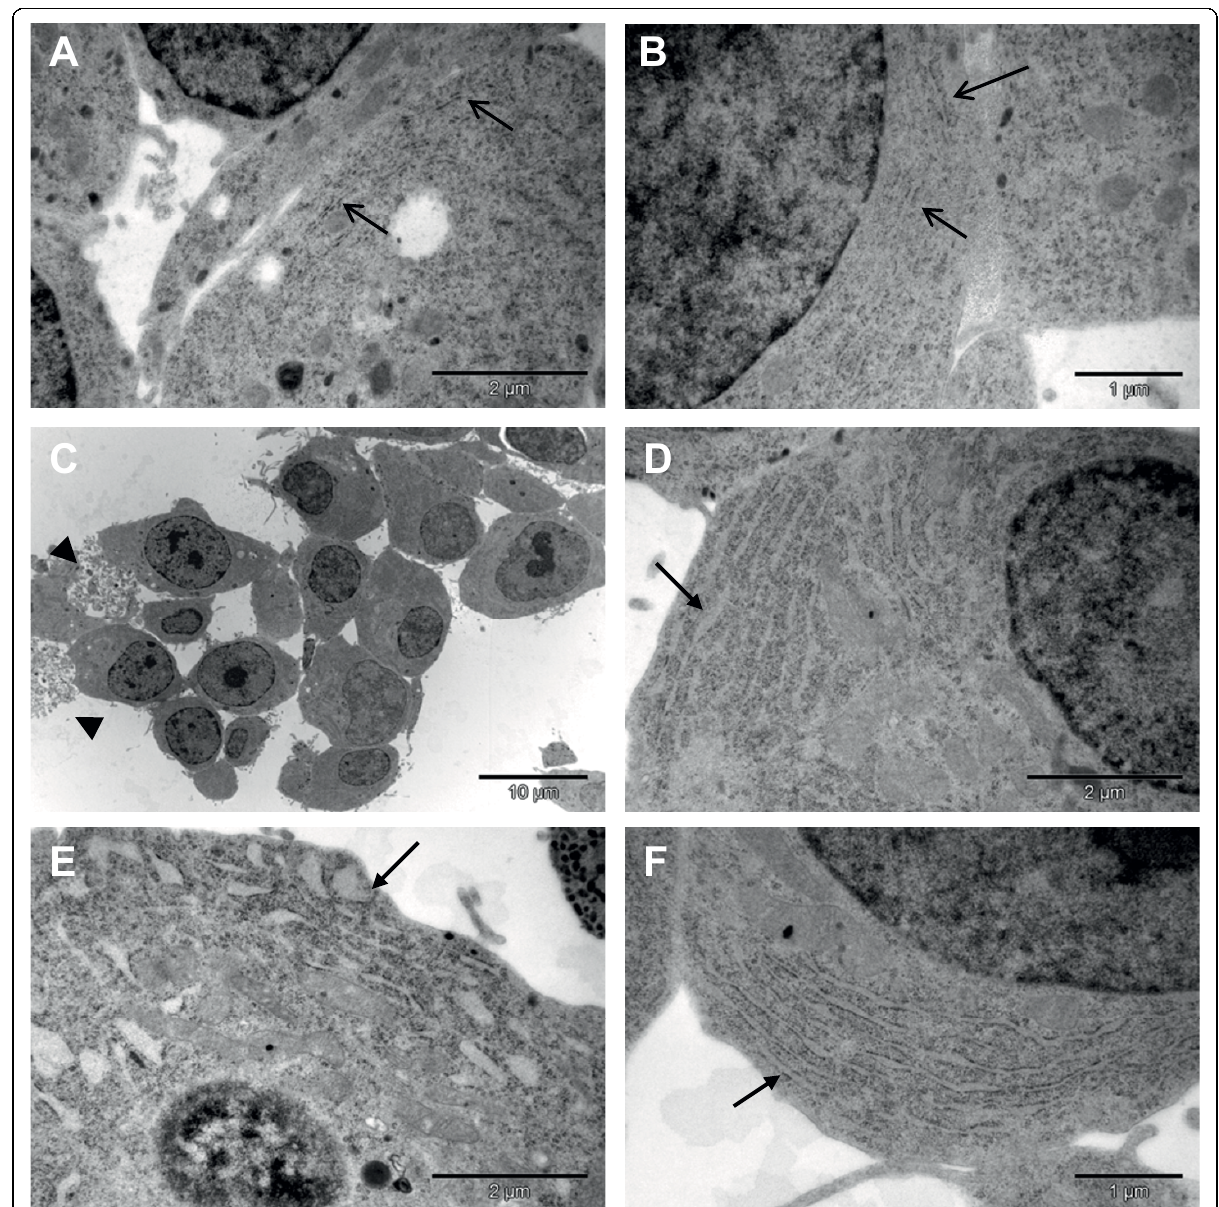
Figure 3 Effect of insulin 2 (C96Y)-EGFP expression on ER morphology . Clone #4S2 cells untreated (A, B) or treated with 2 μ g/ml doxycycline for 3 days (C, D) or 6 days (E, F) were washed in PBS and fixed. The cells were processed for transmission electron microscopy as described in the methods. ER structures in uninduced cells (A, B, arrows), and distended ER structures in mutant insulin expressing cells following doxycyline-induction (D-F, arrows) are indicated. The presence of apoptotic cells was evident in doxycyline-induced cells (C,